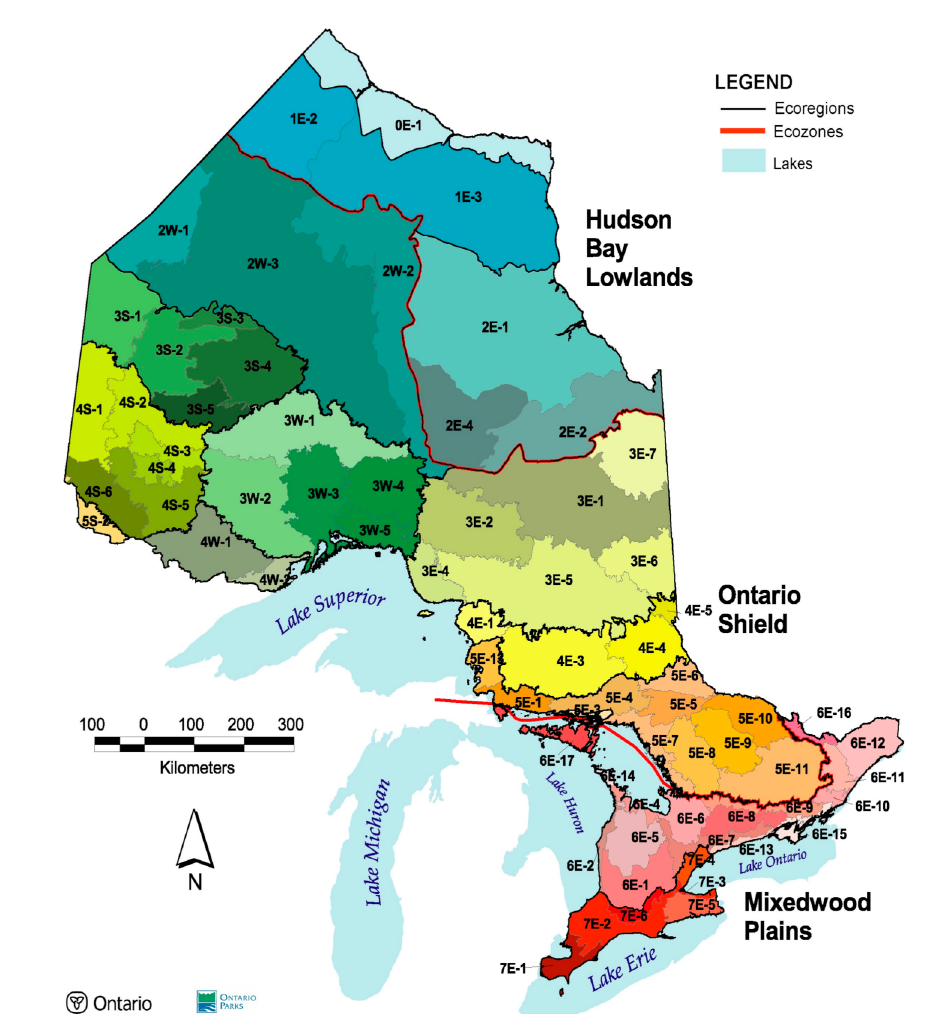
Figure 1. Map showing the ecozones, ecoregions and ecodistricts of Ontario, Canada. (Source: Crins, W.J., Gray, P.A., Uhlig, P.W.X., Wester, M.C., 2009. The Ecosystems of Ontario, Part I: Ecozones and Ecoregions. Ont. Min. Nat. Resour., Peterborough, ON, Inventory, Monitoring and Assessment, SIB TER IMA TR-01,